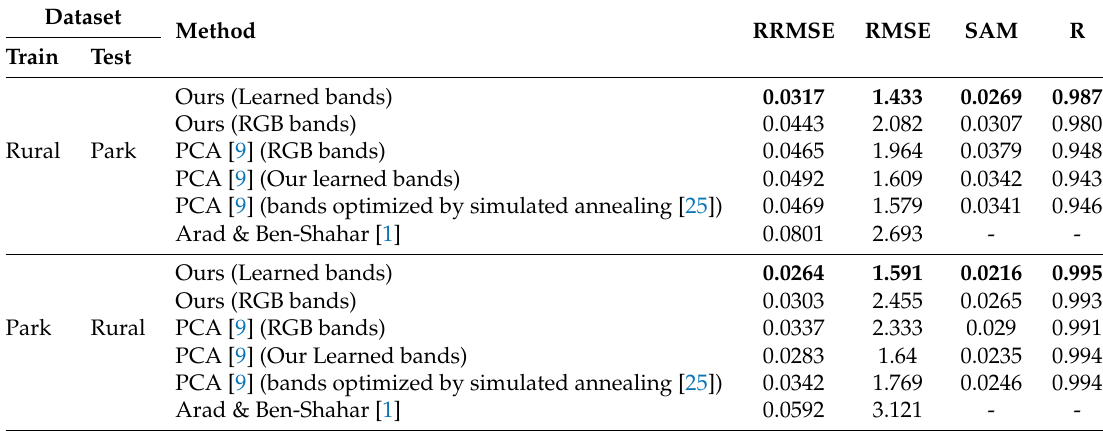
Table 1. Comparison of reconstruction accuracy on Outdoor scenes